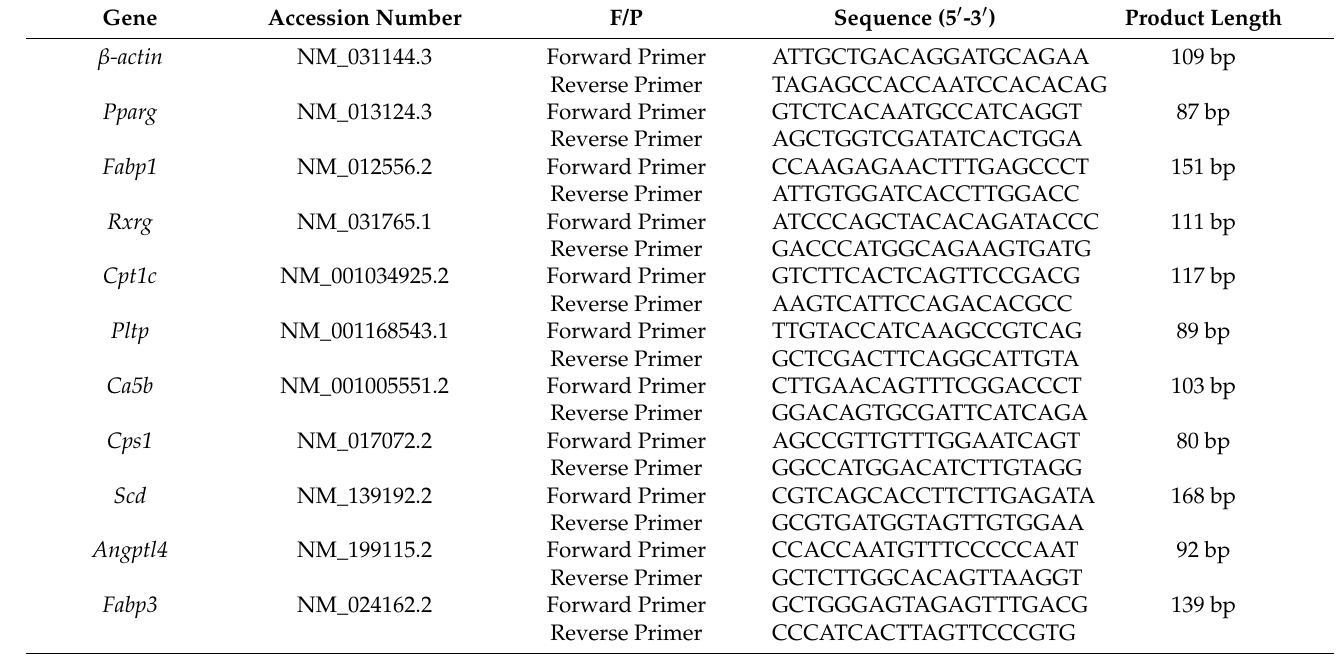
Table 2. Sequences of the PCR primers used in gene expression